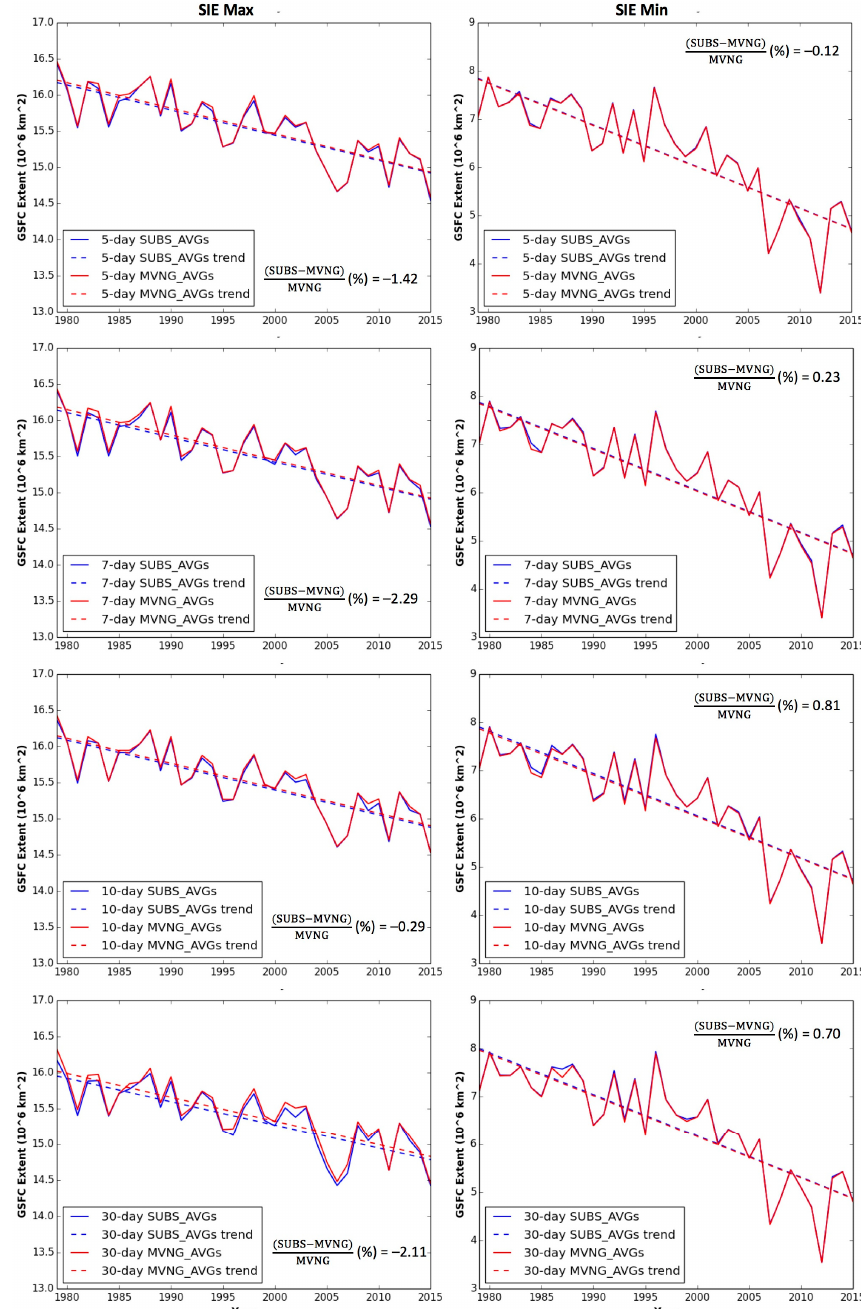
Figure 1. Time series (solid) of annual Arctic sea ice extent (SIE) maximums (left panels) and minimums (right panels) and their linear trends (dashed) for moving (red) and subsetting (blue) averaging methods. Plots for different time intervals (5-, 7-, 10-, and 30-day) are shown, along with the percentage change of decadal trends. The five-day moving average is a widely adopted method in the cryosphere community, and the 30-day subsetting average is similar to a monthly average.